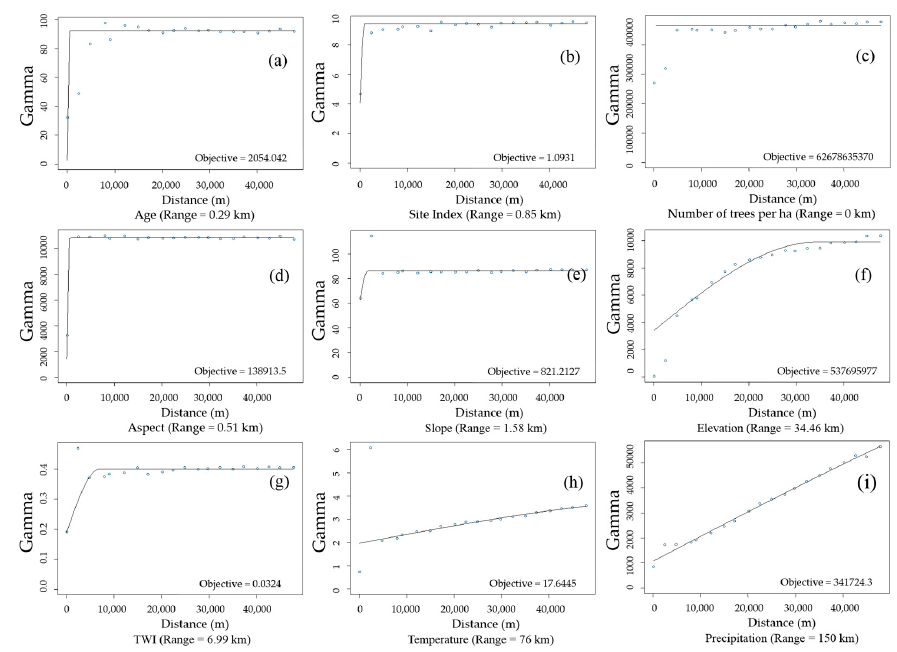
Figure 4. Analysis of spatial autocorrelation by using factors that affect DBH estimation at the stand level ((a), (b), (c), (d), (e), (f), (g), (h) and (i) represent spatial autocorrelation of age, site index, number of trees per ha, aspect, slope, elevation, TWI, temperature and precipitation, respectively).